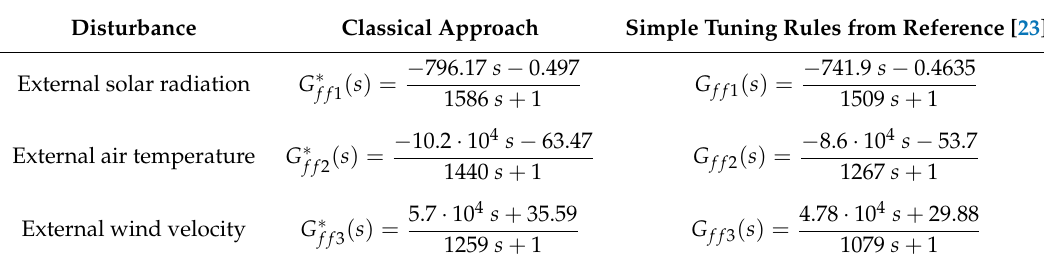
Table 1. Feedforward compensators